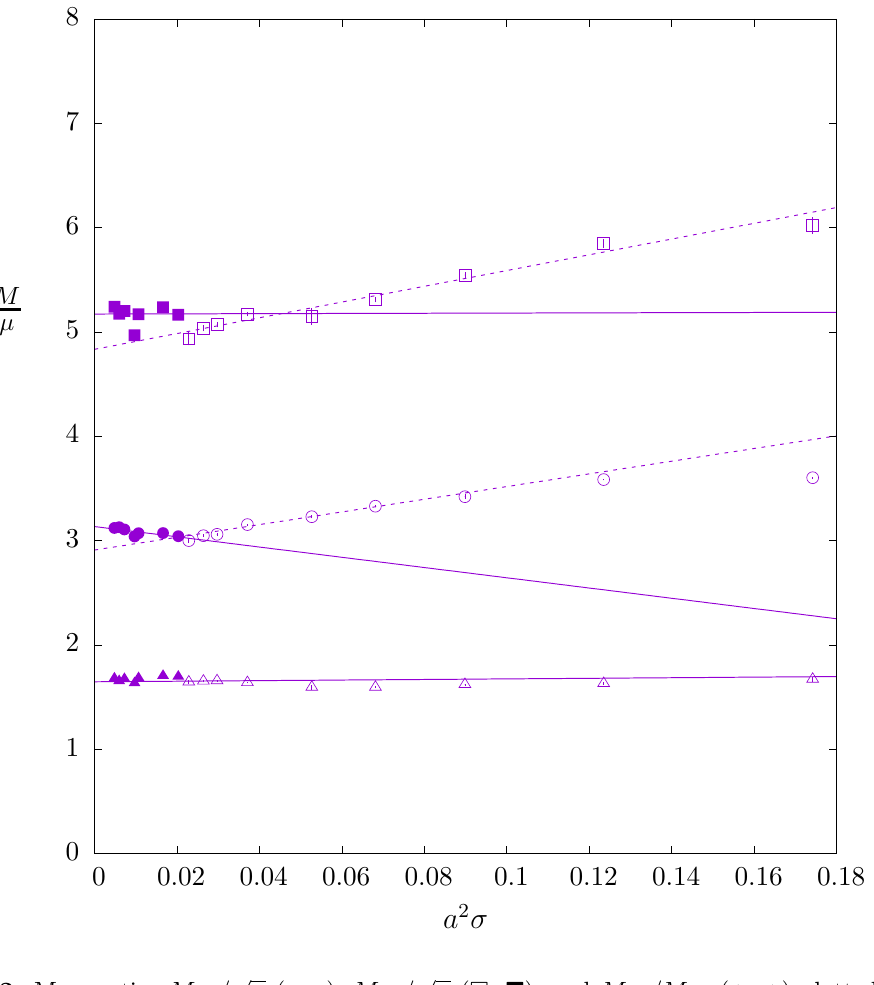
Figure 32 . Mass ratios M a 2 (cid:27) , with open and (cid:12)lled at strong and weak coupling respectively; all in SO(3). Linear (cid:12)ts to strong and weak coupling values shown as dashed and solid lines